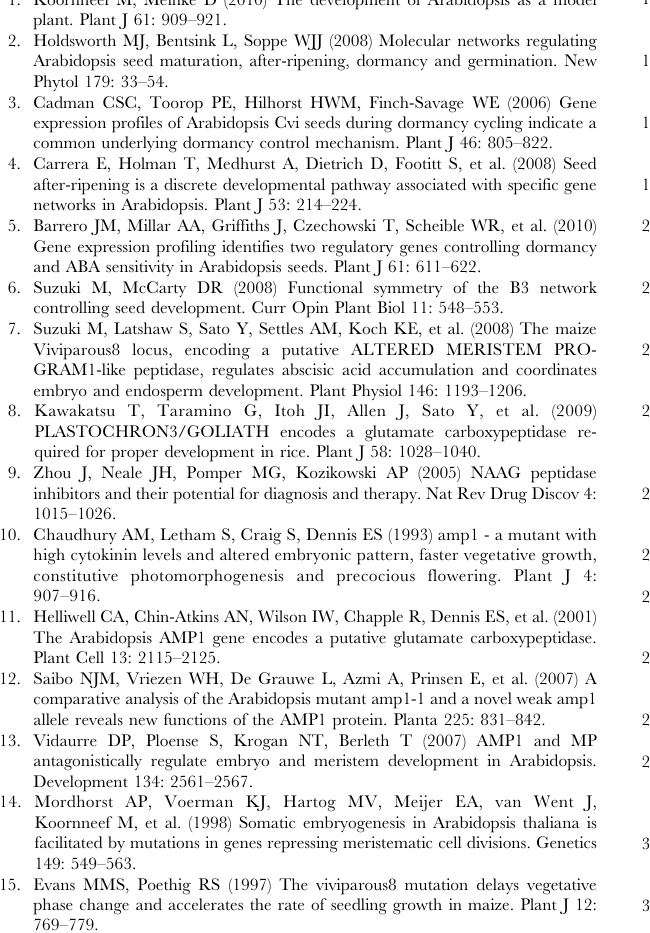
Table S3 Probes differentially expressed in amp1-21 . Table S4 Probes differentially expressed in both amp1-1 and amp1-21 . Table S5 Probes differentially expressed only in amp1-1 . Table S6 Probes differentially expressed only in amp1-21 . Table S7 Primers used in this